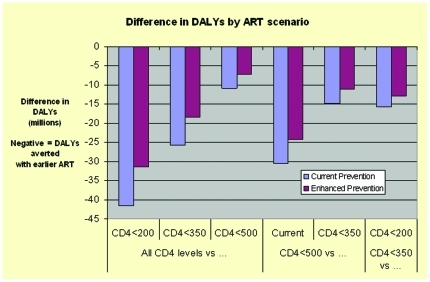
Difference in DALYs by ART scenario, 2010–2050 (discounted to 2010).This bar chart represents the difference in Disability Adjusted Life Years (DALYs) between different ART scenarios, over 40 years (discounted to 2010). The ART scenario comparison is indicated in the horizontal axis label. The DALY difference is indicated on the vertical axis (in thousands). Negative numbers indicate fewer DALYs with more use of ART, representing lower disease burden. Findings with current prevention are indicated in blue, and with enhanced prevention in maroon. The differences between ART scenarios are greater under current prevention impact than assumed enhanced prevention impact.